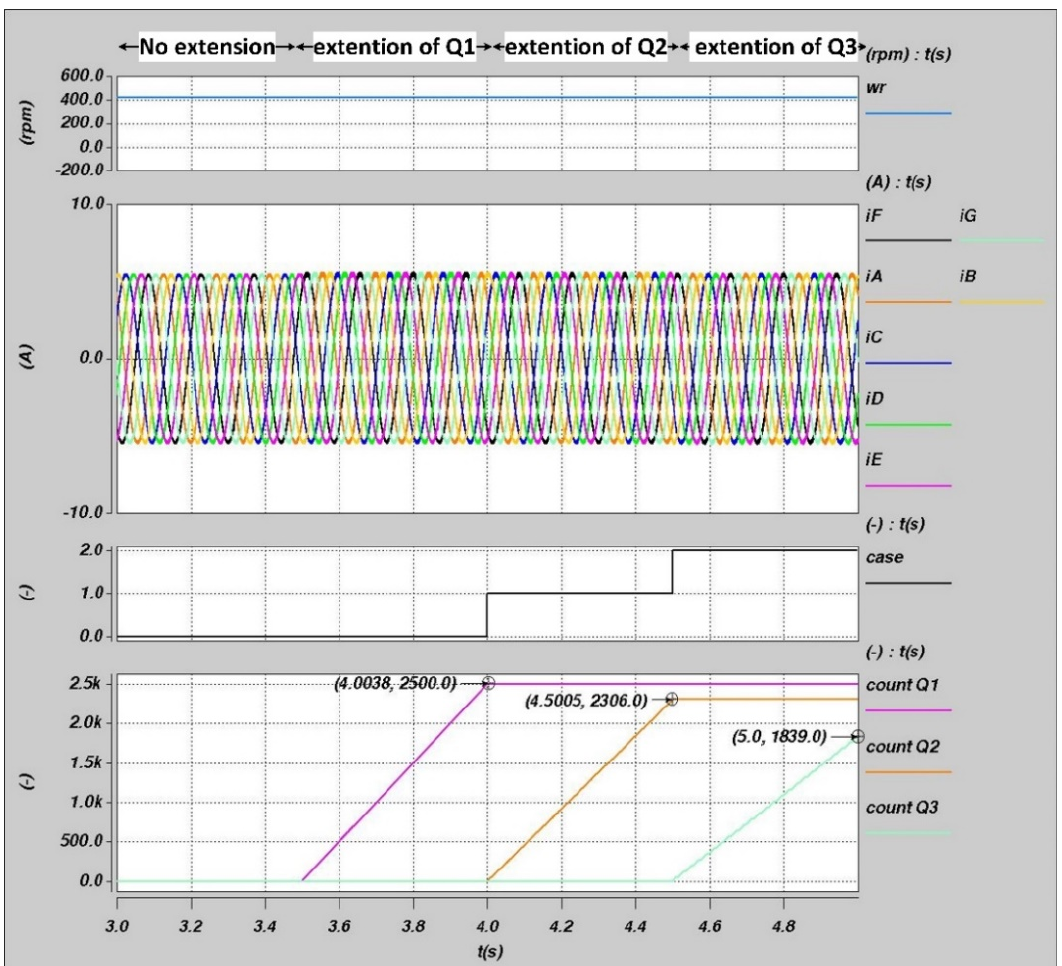
Figure 19. Current waveforms at 90 rpm using different extension schemes.